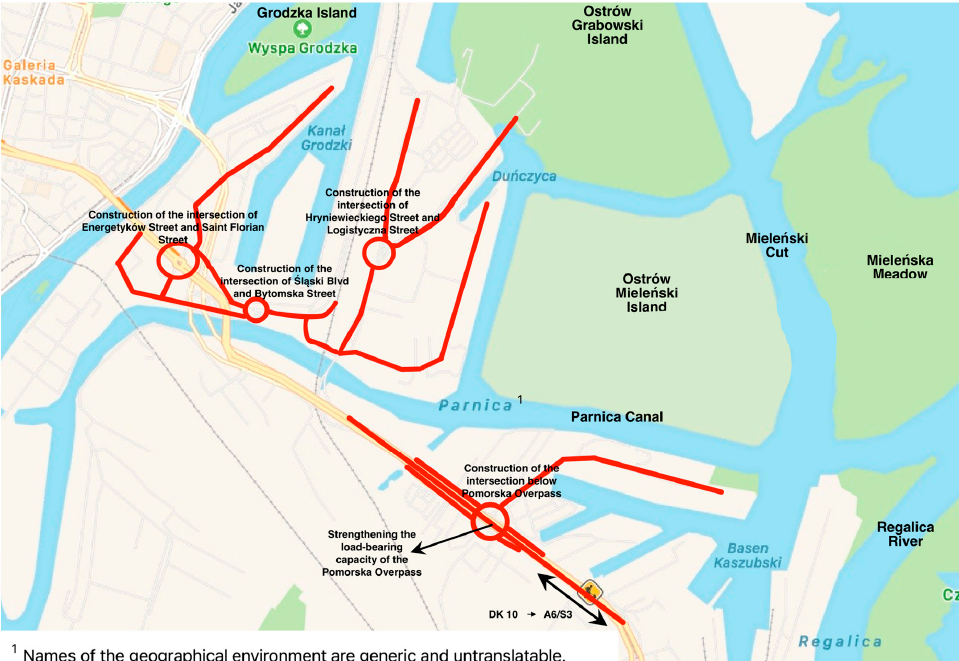
Figure 2. Scope of intervention in urban-port road system. Source: own study based on www. openstreetmap.org (accessed on 24 June